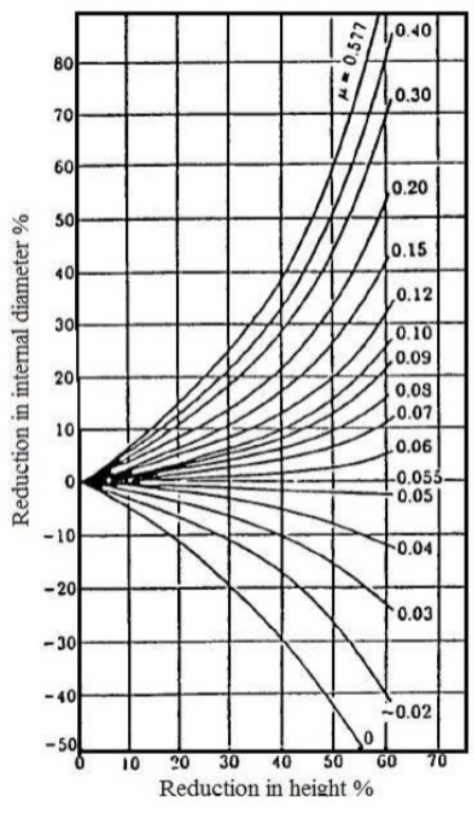
Figure 2: The calibration curve for calculating the f